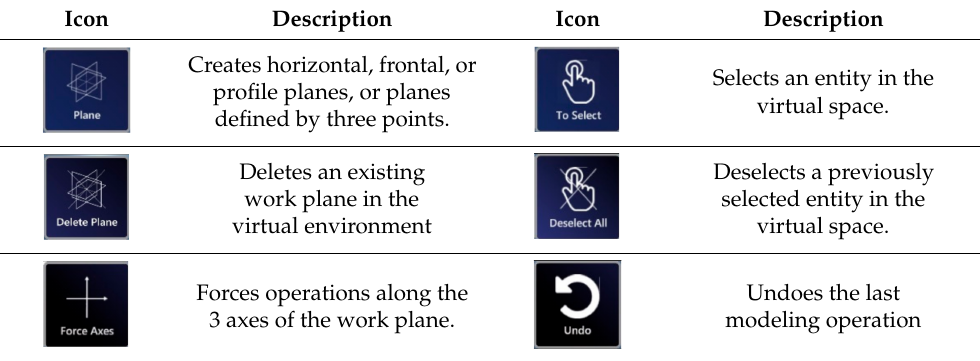
Table 4. Modeling